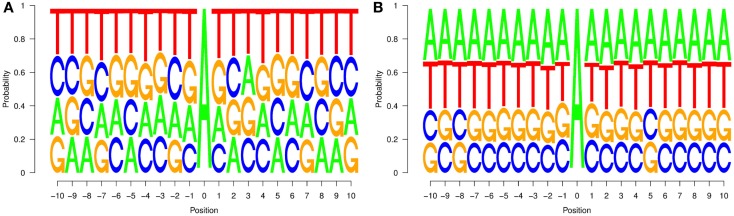
Neighborhood preferences that we computed for experimentally verified editing sites in non-repetitive regions (A) and random sites (B) chosen among those for which no editing event is reported. Neighborhood preferences are coherent with the upstream nucleotide distribution of editing site sequence contexts reported in Eggington et al. (2011).